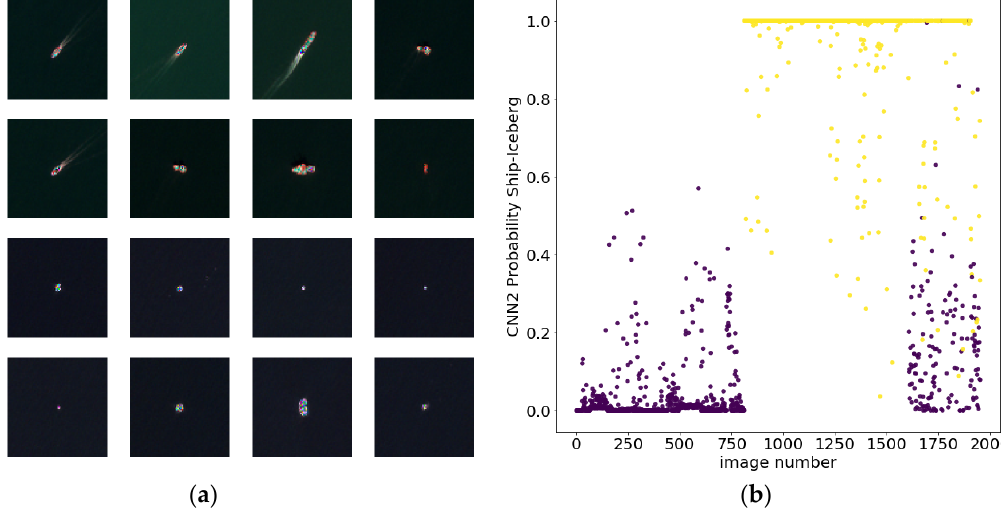
Figure 5. As Figure 4 but for the Sentinel-2 multispectral imaging (MSI) dataset. ( a ) RGB images of ships and icebergs. The scatter plot in ( b ) shows the ship, iceberg, and Nuuk datasets merged sequentially by image